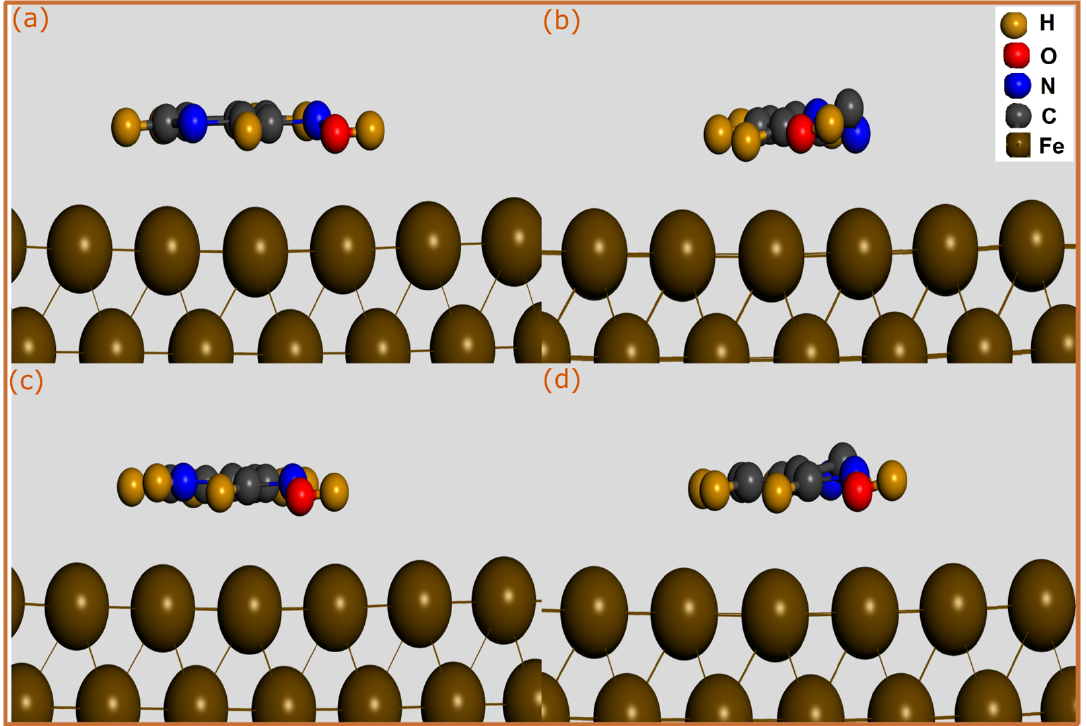
Figure 6. The most stable adsorption configurations of pyridine molecules adsorbed on Fe(110) sur- face in vacuum phase obtained by MD simulations; ( a ) 2POH, ( b ) 3POH, ( c ) 2POH + and ( d ) 3POH + .